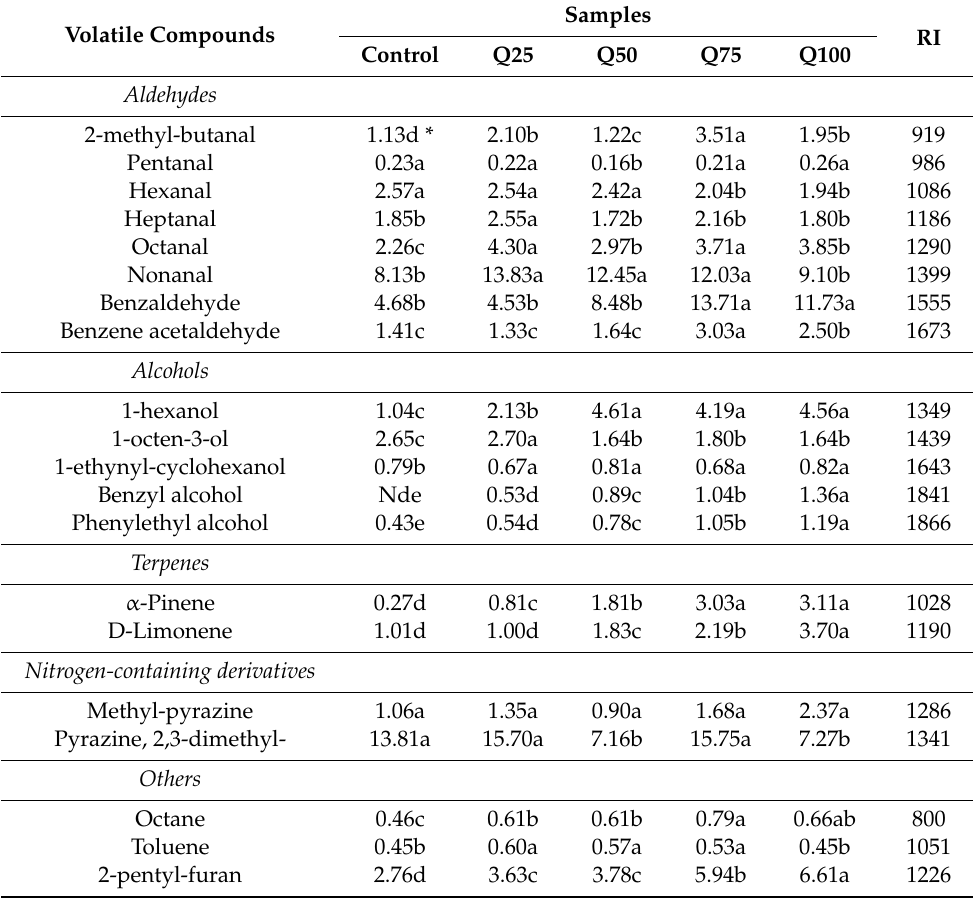
Table6. VolatileorganiccompoundstentativelyidentifiedinladyfingerGFbiscuitsbyHS-SPME-GC / MS. Results are expressed as chromatogram peak area [ × 10 6